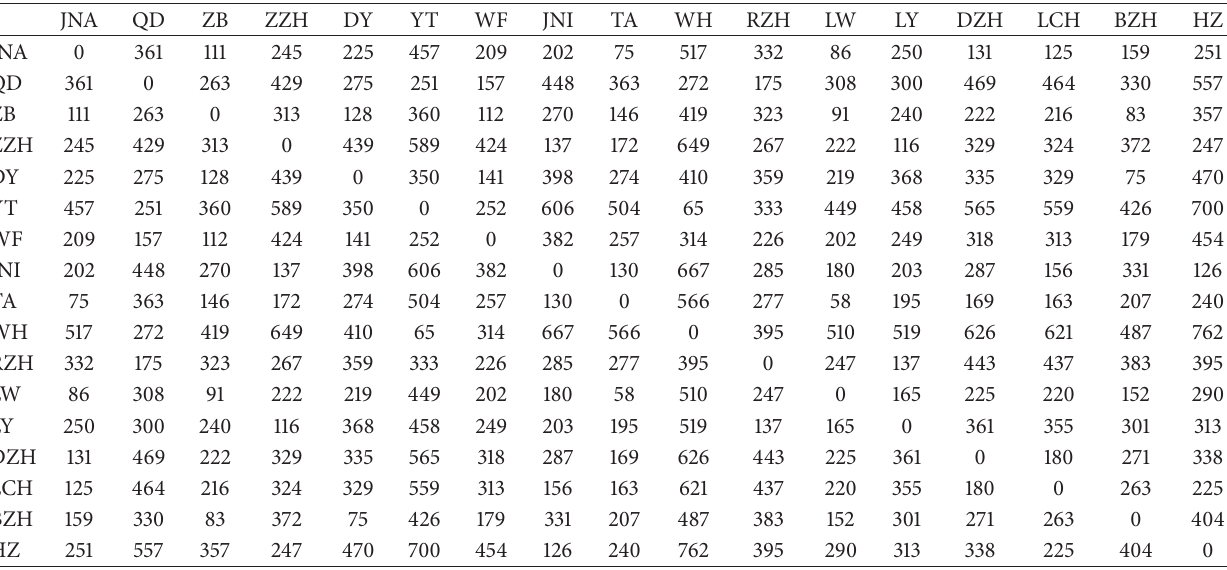
Table 3: The distances between any two cities (km).